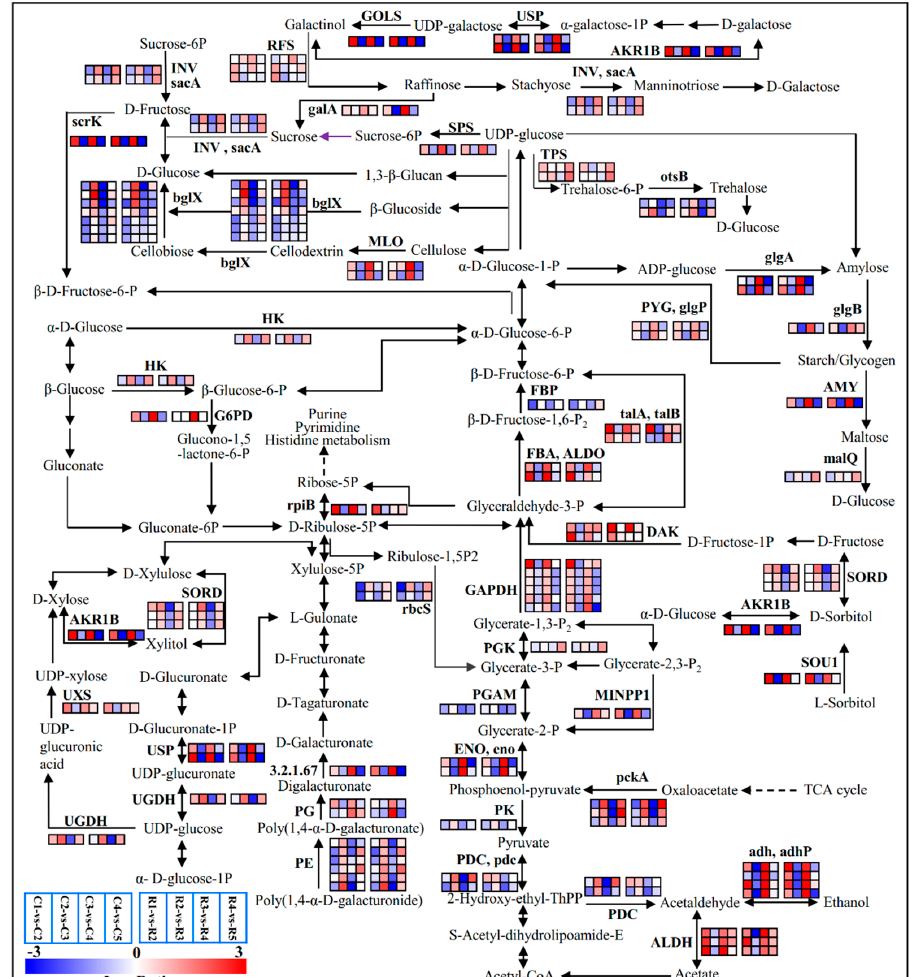
Figure 4. Significantly expressed genes involved in starch and sucrose metabolism, Glycolysis/Gluconeogenesis, the pentose phosphate pathway, Fructose and mannose metabolism, galactose metabolism, and the Pentose and glucuronate interconversions pathway during the differentiation phases of flower buds. Color codes from blue to red indicate changes in transcriptional expression levels between − 3 and 3. The boxes from left to right indicate the expression values of a unigene obtained in C1 vs C2, C2 vs C3, C3 vs C4, C4 vs C5; R1 vs R2, R2 vs R3, R3 vs R4, R4 vs R5, respectively. Each row represents a separate unigene. This rule also applies in the next few